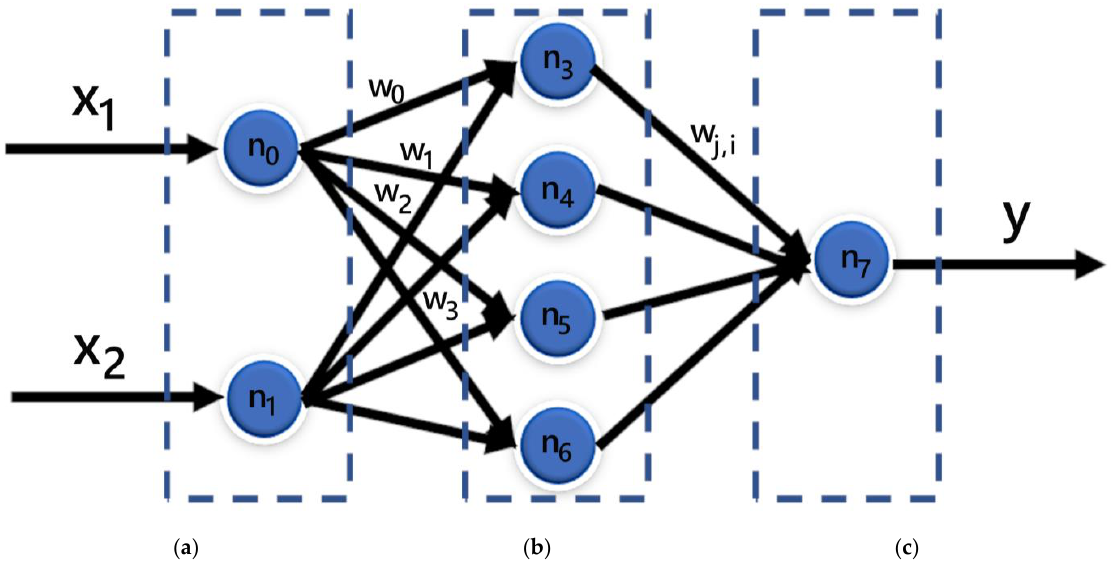
Figure 1. Structure of multi-layer perceptron (MLP): ( a ) input layer; ( b ) hidden layer; ( c ) output layer. Description: i — neuron index, n i — an “i” index neuron, w i — the weigh vector of “i” neuron connections, w j,i — the weigh vector of connections from the previous layer with neuron from the present layer, x — input descriptors, y — output descriptors.